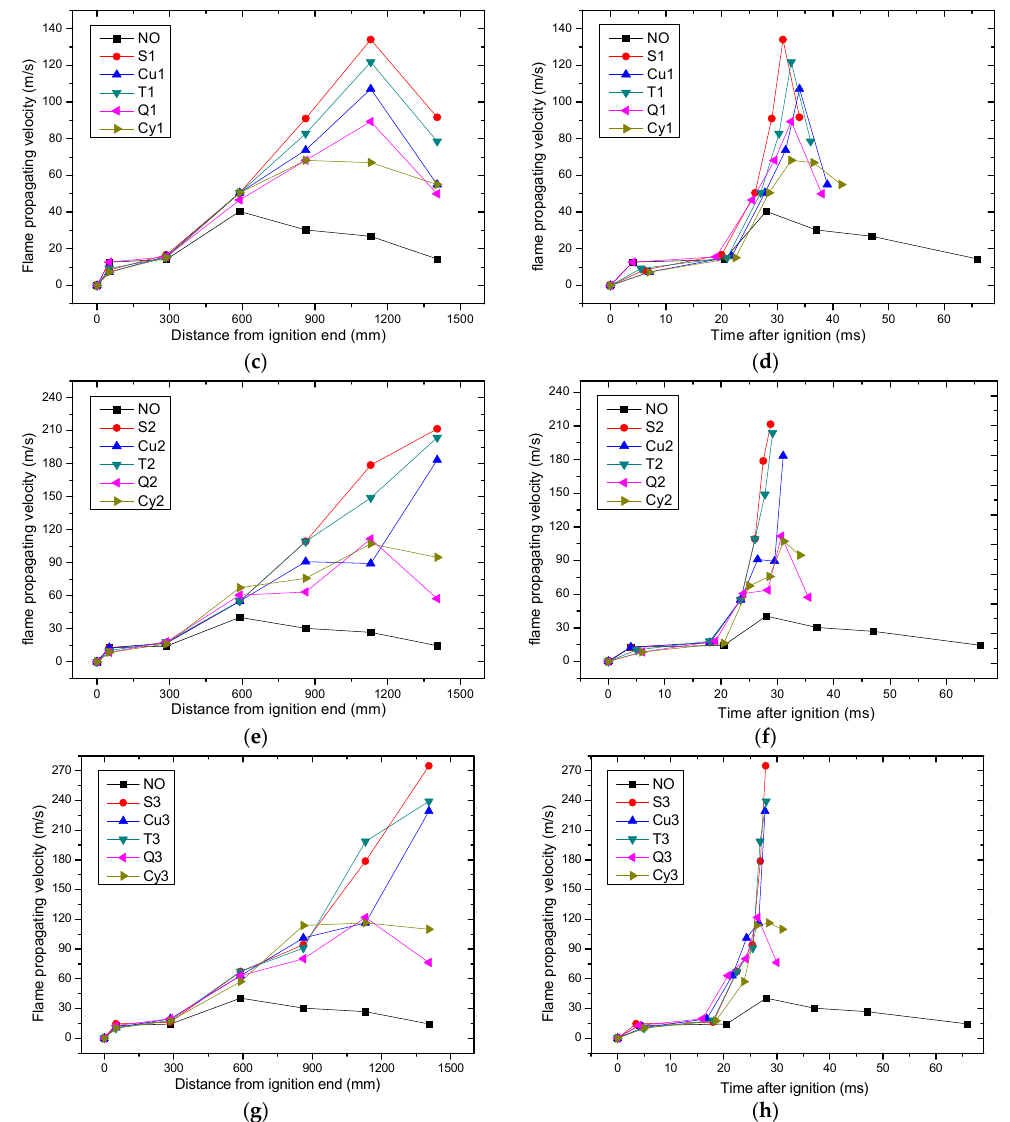
Figure 6. Flame propagation velocities for placed repeated baffles in tube, 9.47 vol % CH 4 : ( a , b ) flame propagation velocities for placed different shapes of solid structure obstacles in tube, 10.50 vol % CH 4 ; ( c , d ) BR = 20%; ( e , f ) BR = 40%; and ( g , h ) BR = 60%.